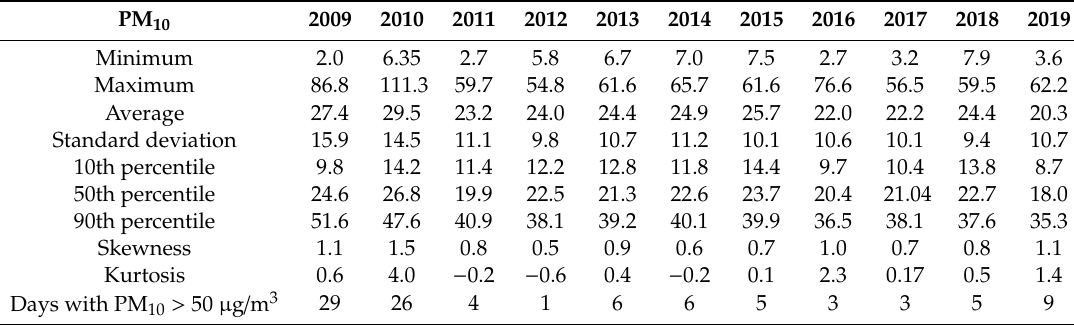
Table 1. Basic statistics of the annual PM 10 concentrations ( µ g / m 3 ) in Cluj-Napoca for